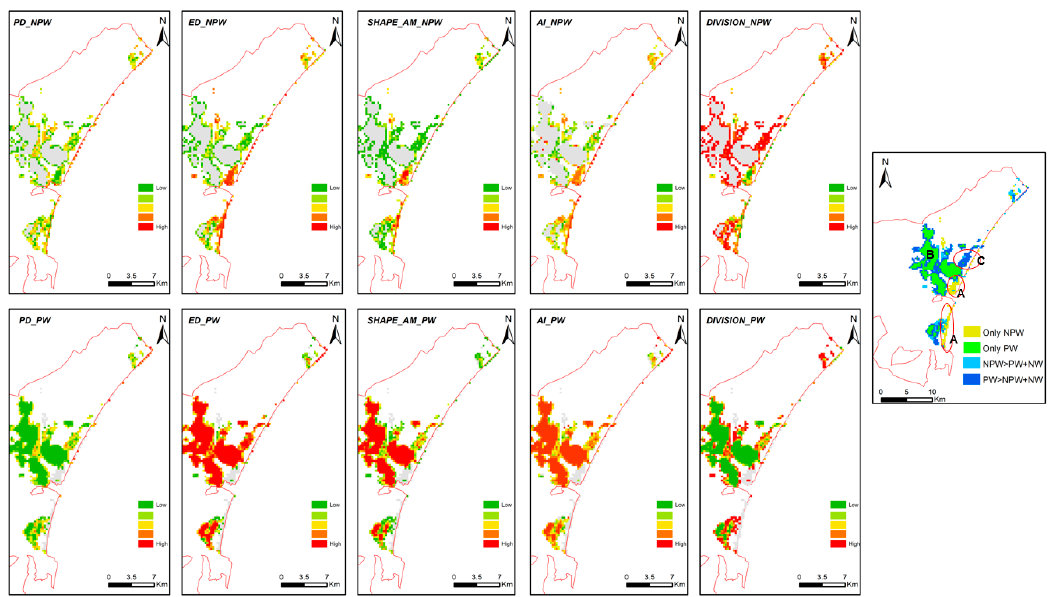
Figure 7. Map of the average value of landscape metrics at the level of surface water scenario for the entire time series 2002–2016. The sub-graphs in top and bottom rows represent the landscape metrics of non-permanent water (NPW) and permanent water (PW), respectively. The sub-graph in right represents the spatial location of PW and NPW cells in the study area.